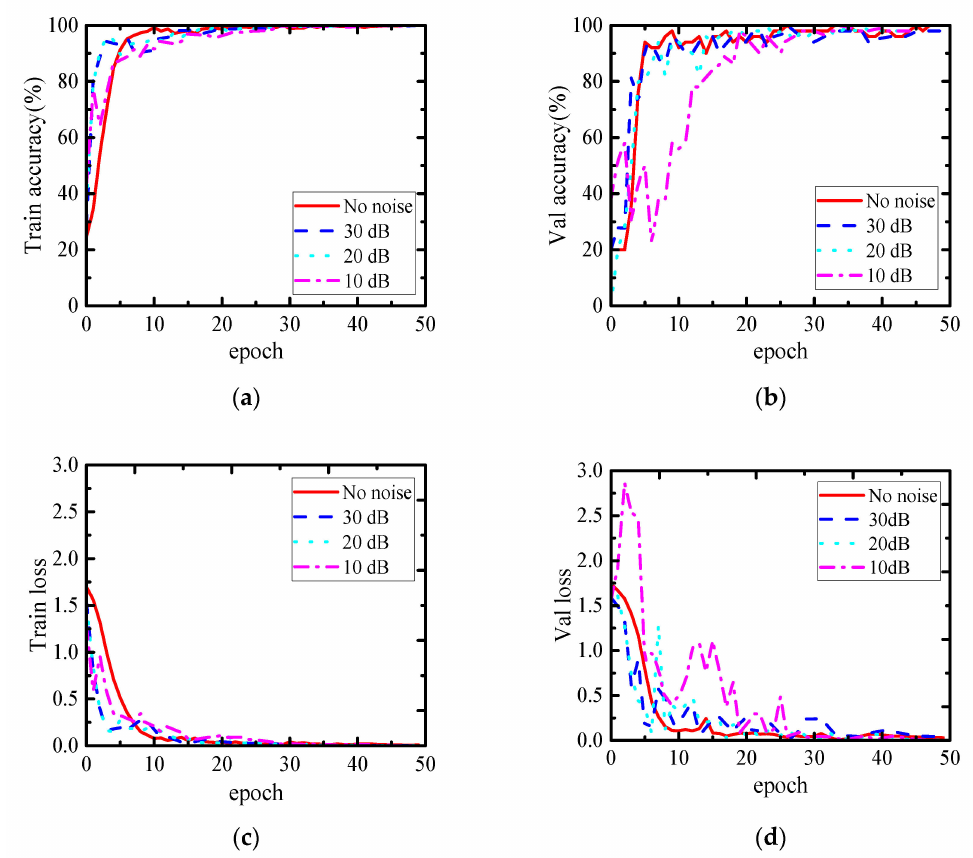
Figure 15. Results of vehicle speed identification under different noise levels: ( a ) Training accuracy curves of response samples; ( b ) Validation accuracy curves of the response samples; ( c ) Training loss curves of the response samples; ( d ) Validation loss curves of response